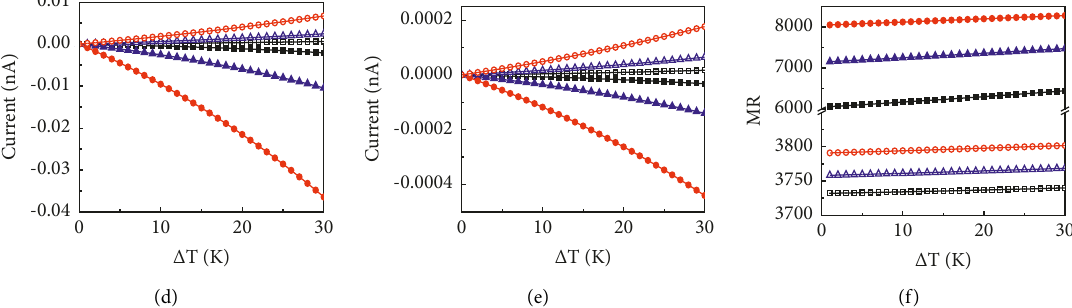
∆ T , (a) and (d) closed Figure 5: The thermally driven spin-related currents I up and I dn in the thermal spin devices ( R (cid:31) CH 2 ) versus T L and state; (b) and (e) open state. (c) and (f) the corresponding switching ratio of the thermal spin devices versus T L and ∆ T , respectively.